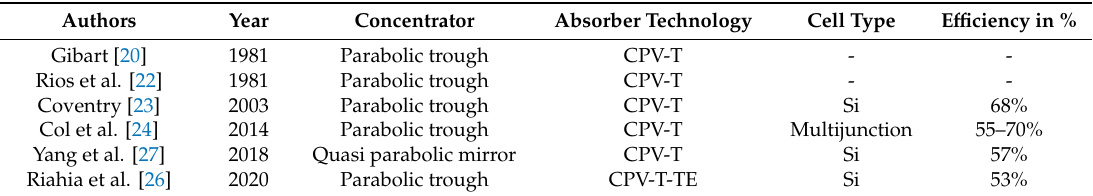
Table 1. Overview of important research and development activities in the CPV-T